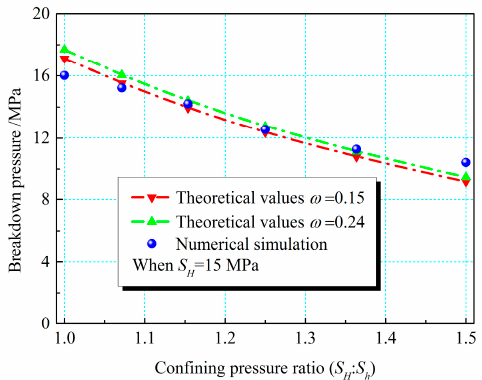
Figure 16. Comparison of breakdown pressure under different confining pressure ratios obtained by the theoretical equation and numerical simulations.